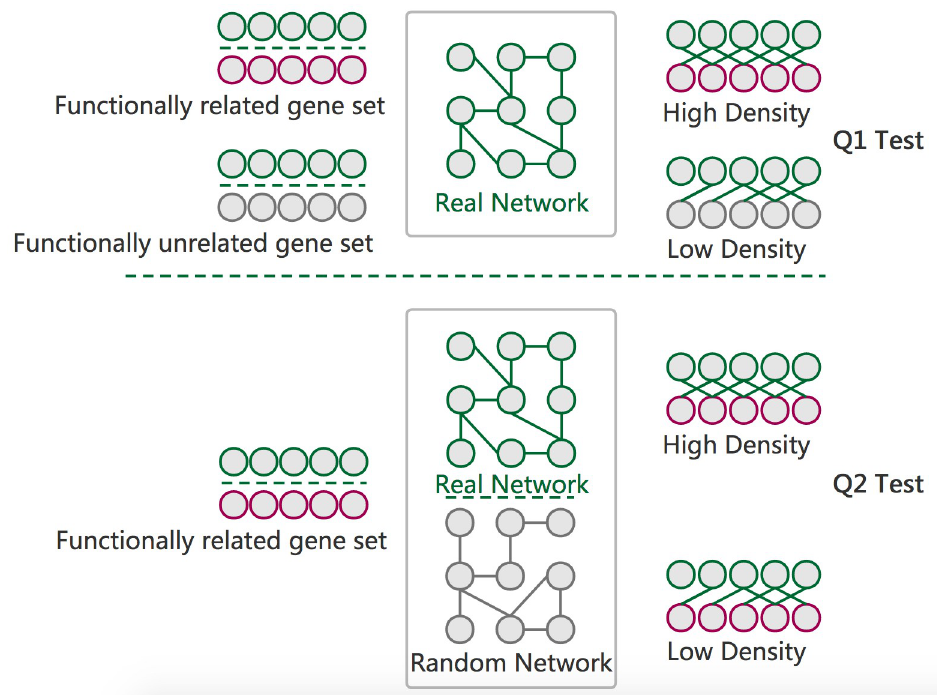
Fig 4. The GSLA interpretation strategy. GSLA uses two hypothesis tests to identify biologically significant functional associations between two gene sets. Q1 evaluates whether the inter-gene-set interaction density between two gene sets is higher than that between random gene pairs. Q2 evaluates whether the dense functional interactions between gene sets can only be observed within the biologically correct network, rather than in randomly generated interactomes with the same node degree